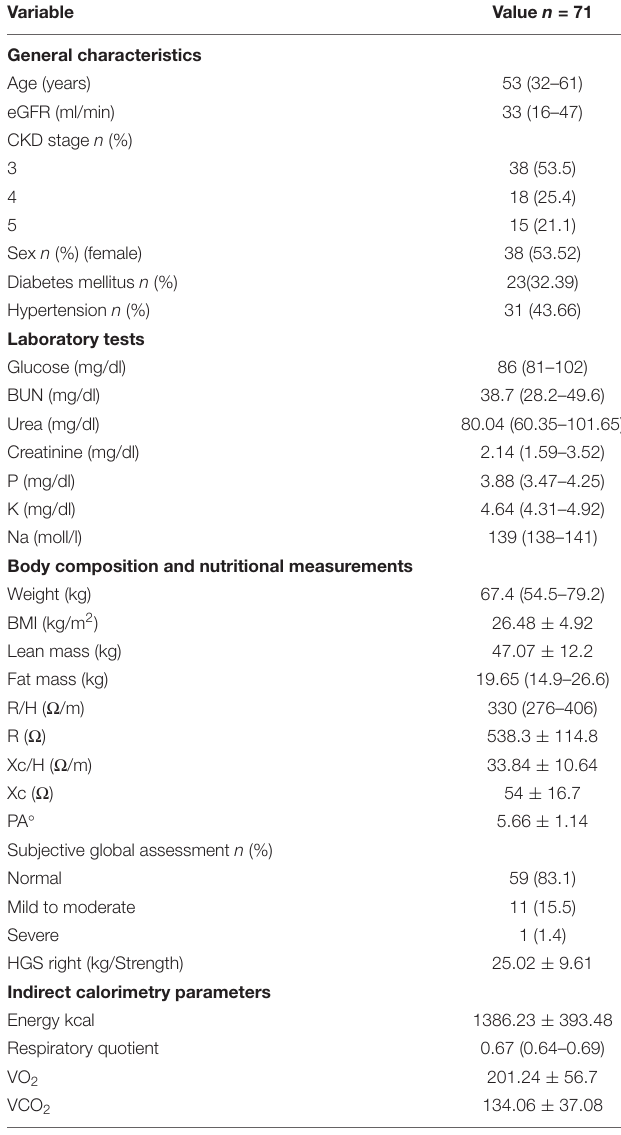
TABLE 1 | General characteristics of the study